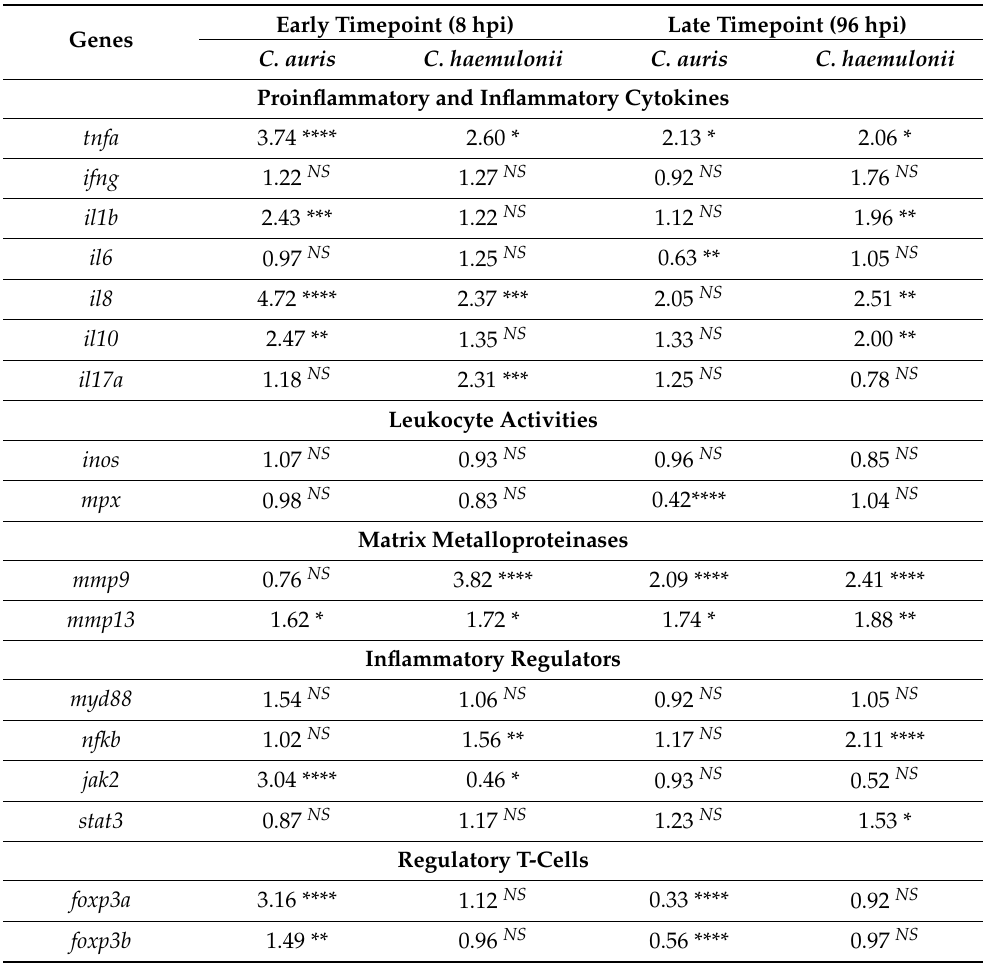
Table 2. Fold changes of gene expression levels of zebrafish infected with C. auris and C. haemulonii at different timepoints, compared with C. albicans